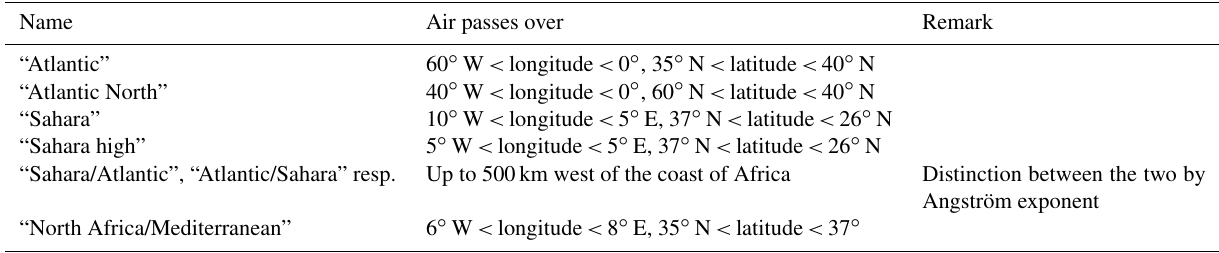
Table 1. Classification of back